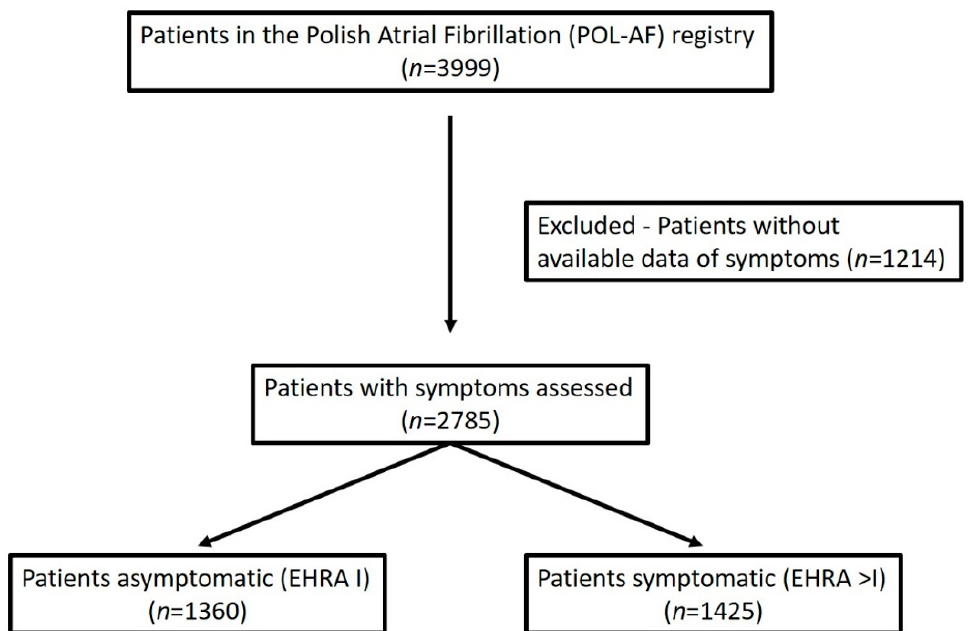
Figure 1. Flowchart of the analysis. EHRA—European Heart Rhythm Association score. A multivariable logistic regression analysis was performed with parameters that were statistically significant in direct comparisons (asymptomatic vs. symptomatic patients) if data were available for more than 80% of cases. For this analysis, the level of significance was set at 0.05. Statistical calculations were performed with Statistica v. 12 (Statsoft Inc., Tulsa, OK, USA).